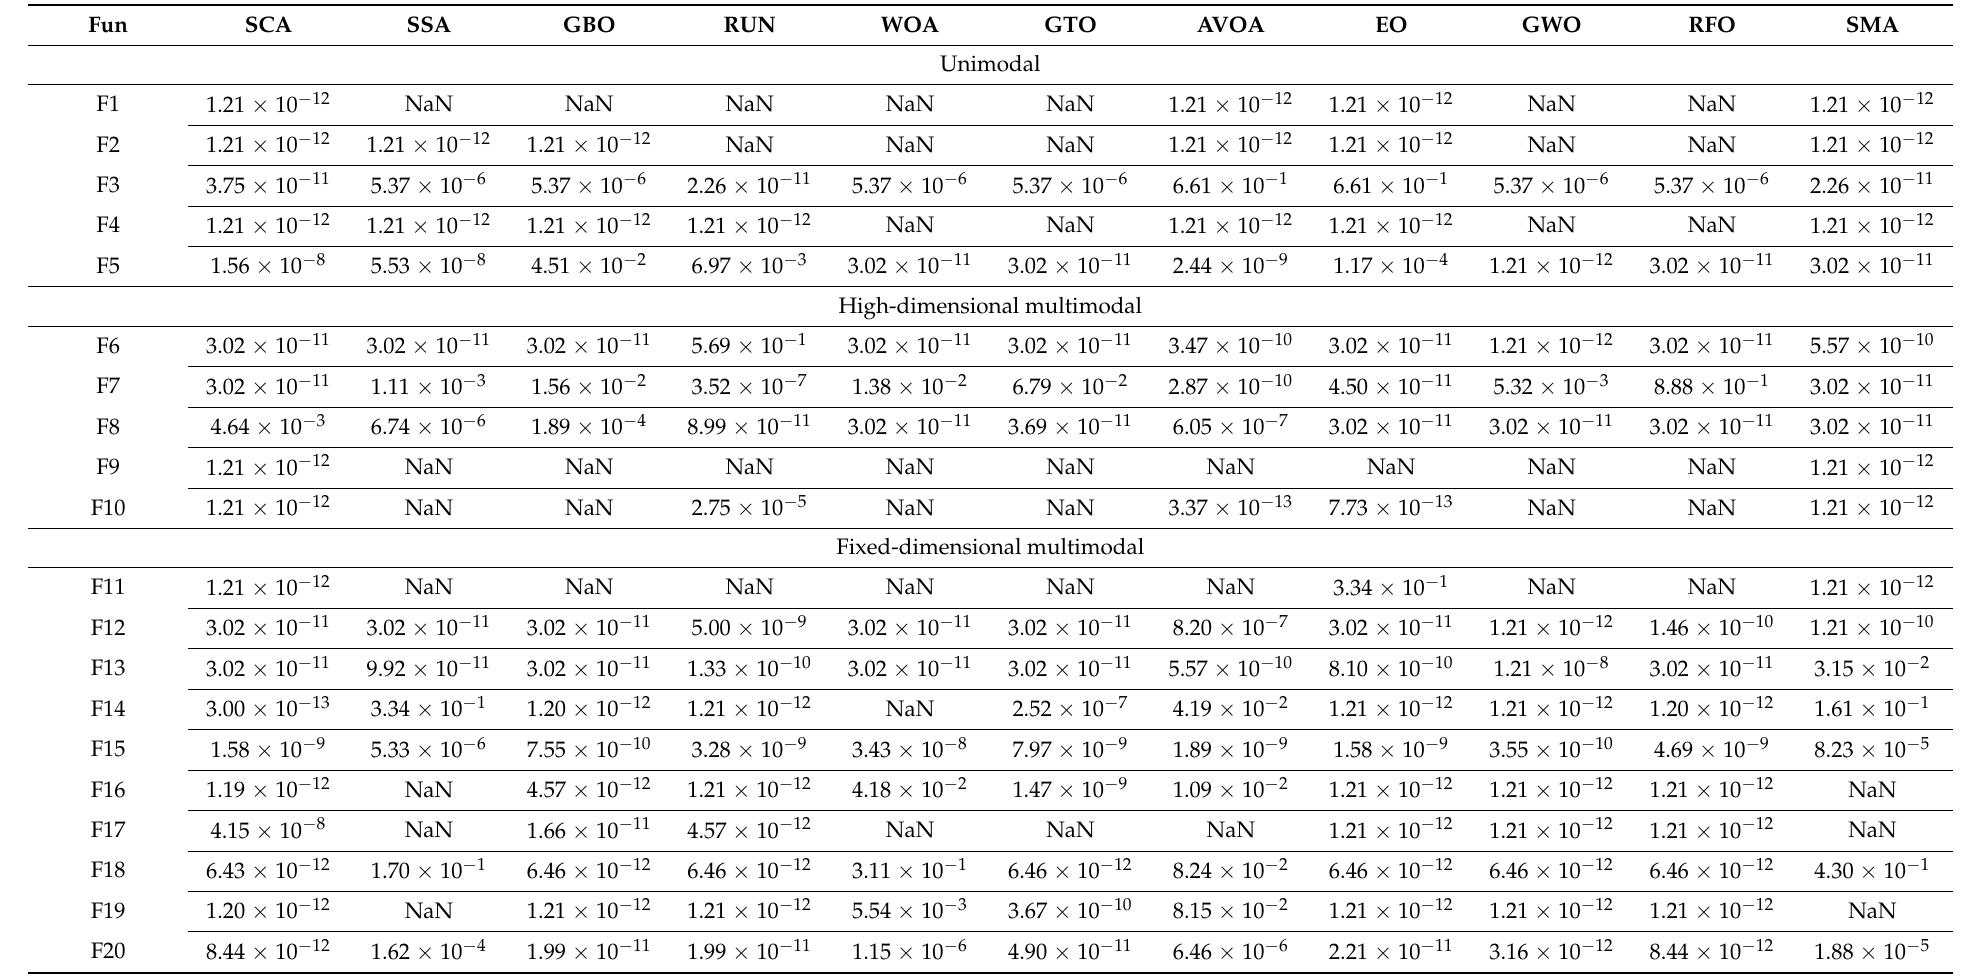
Table 7. p -values of LSO with each rival optimizer on CEC2005 test suite